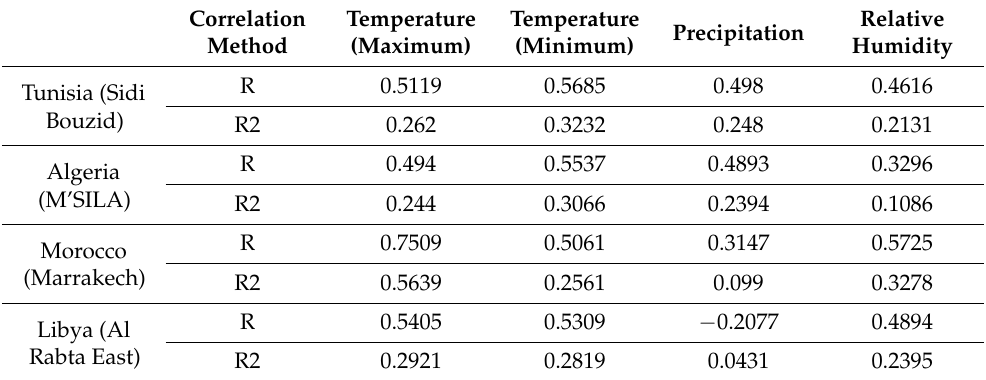
Table 4. Results of the correlation between P. papatasi and climatic parameters as computed with the social science statistics